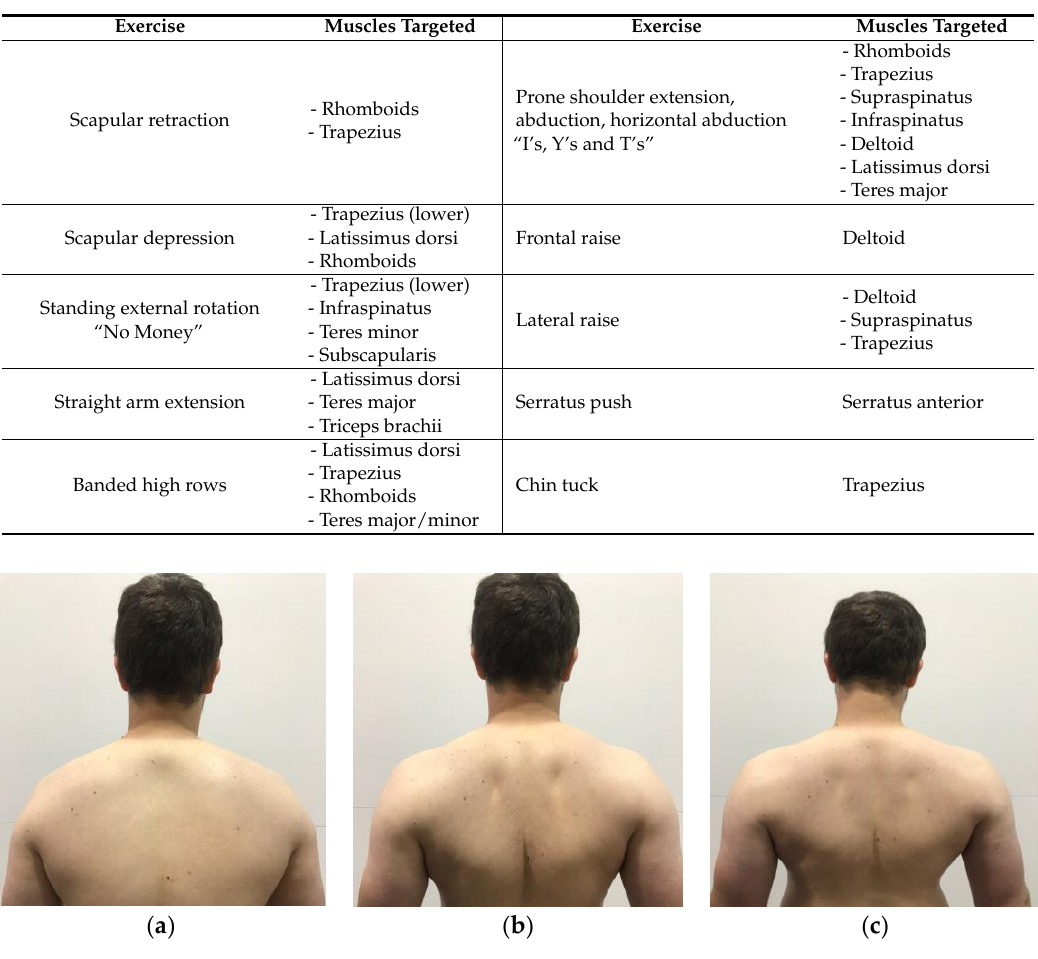
Figure 2. Demonstration of scapular retraction and depression in the ( a ) start position; ( b ) end position of scapular retraction; ( c ) end position of scapular depression. For scapular retraction, emphasis is placed on “pulling” the shoulder blades backwards. For scapular depression, emphasis is placed on “pulling” the shoulders back and down.